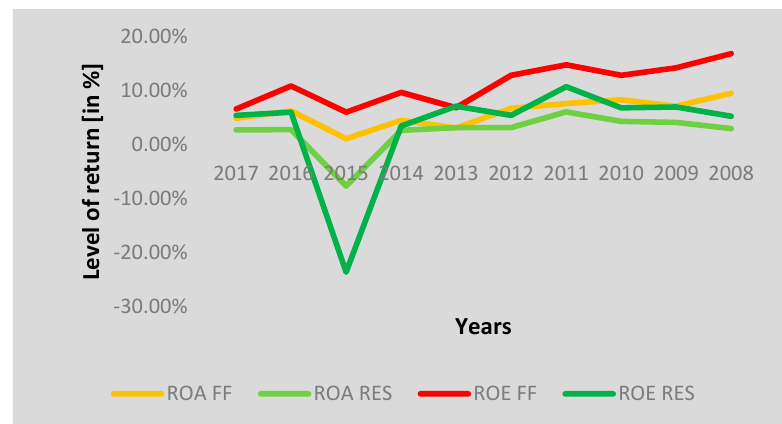
Figure 4. Yearly values of ROA and ROE for two groups of analysed companies, 2008–2017. Source: Own calculations based on data from EMIS database.